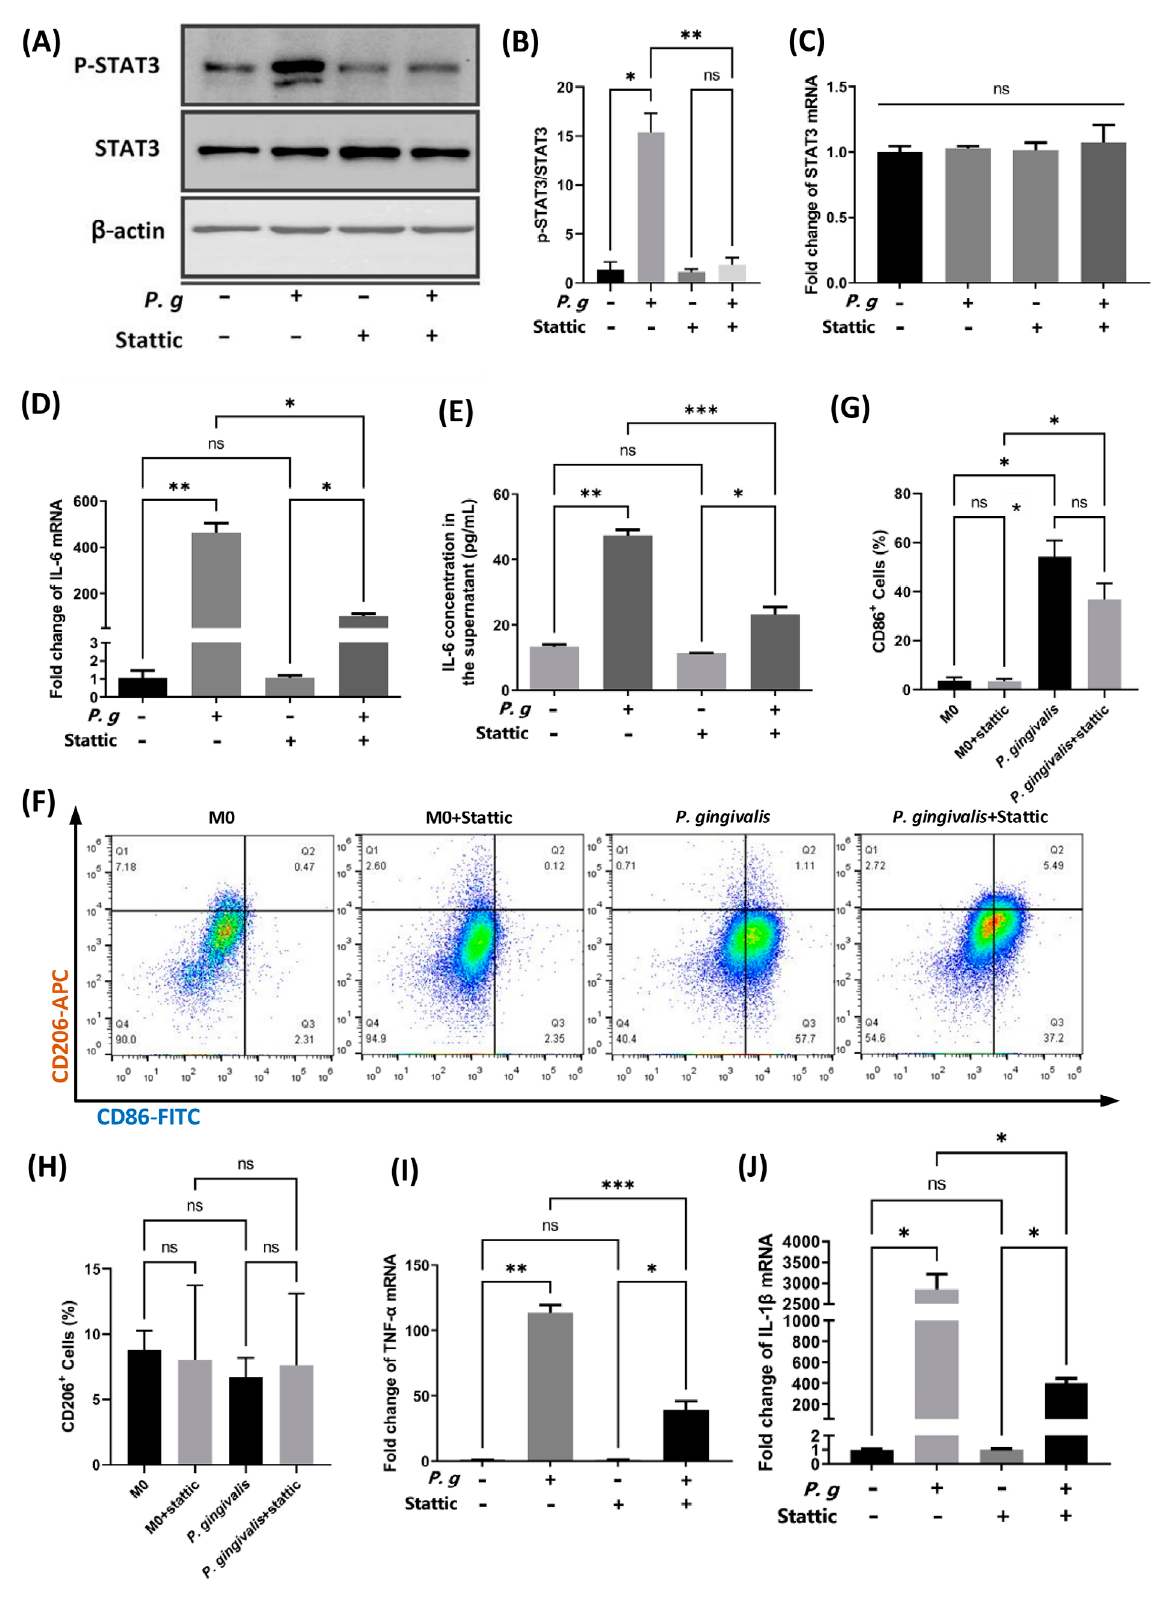
Figure 4- STAT3 blocking attenuated P. gingivalis -induced IL-6 production, STAT3 phosphorylation, and M1 type polarization in murine primary macrophages. (A), representative image demonstrating the phosphorylation status of STAT3 induced by P. gingivalis and suppressed by Stattic. (B), grayscale analysis of p-STAT3 expression (relative to STAT3). (C) and (D), relative mRNA expression levels of STAT3 (C) and IL-6 (D) after P. gingivalis infection for 12 h in the presence or absence of 5 μM Stattic. (E), levels of IL-6 protein secreted in the culture supernatant of BMDMs in response to P. gingivalis infection with or without 5 μM Stattic. (F), representative flow cytometry results exhibiting the influence of Stattic on macrophage polarization status after P. gingivalis stimulation for 12 h. (G) and (H), statistical results for CD86+ (G) and CD206+ (H) macrophages in flow cytometry. M0, unstimulated BMDMs; P. g and P. gingivalis , BMDMs stimulated by P. gingivalis for 12 h. *p<0.05; **p<0.01; ***p<0.001; ns, not